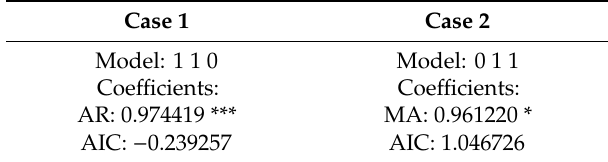
Table 2. The parameters of the autoregressive moving average (ARMA) model. Case 1 Case